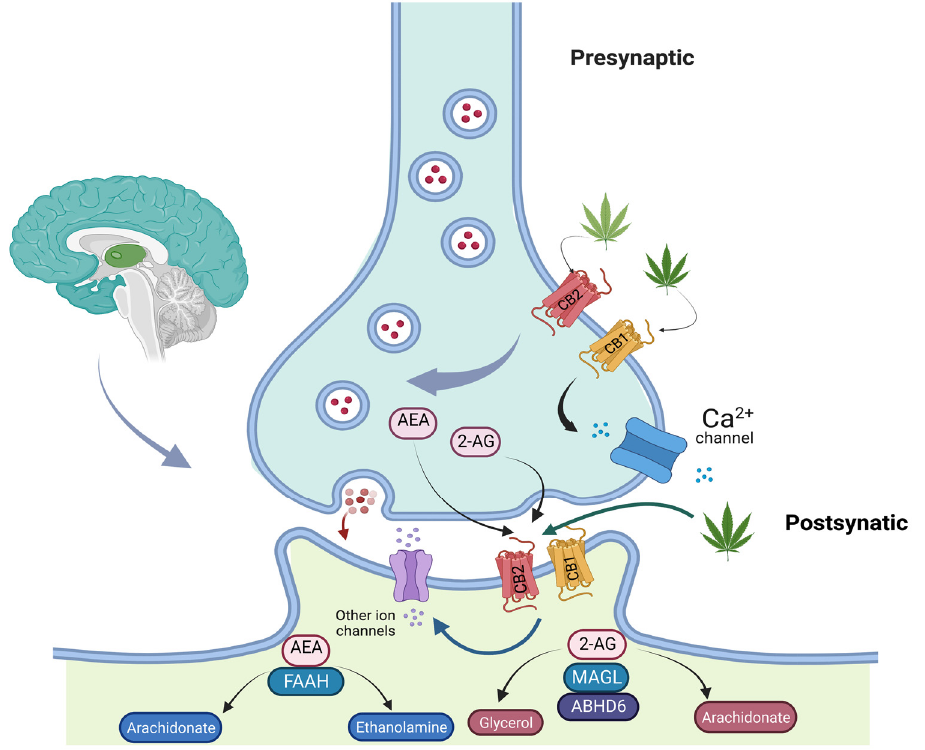
Figure 2. General overview of endocannabinoid system mechanism.